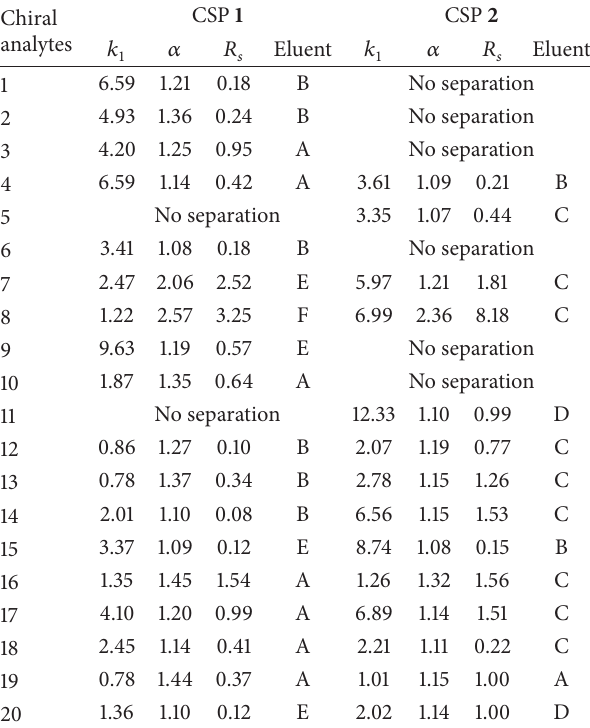
Table 1: The enantioseparation evaluation of CSP 1 and CSP 2 . Chiral